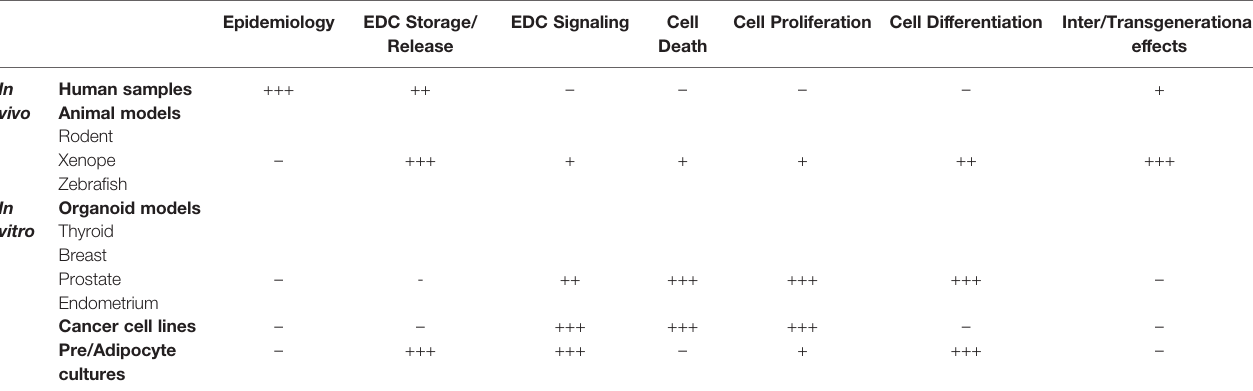
TABLE 1 | Overview of in vivo and in vitro models available to study the adverse effect of